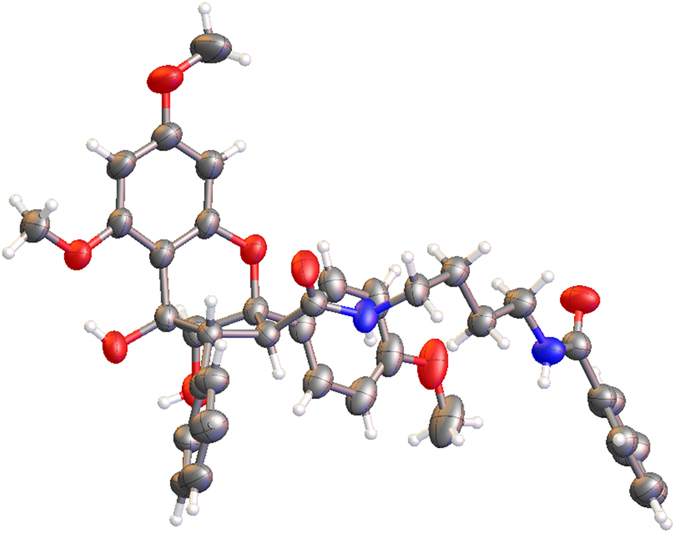
Single-crystal X-ray structure of 2.